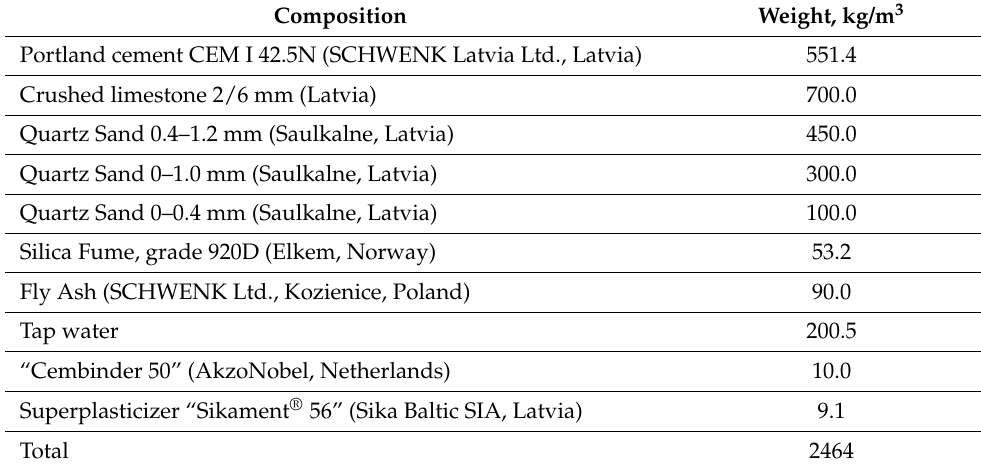
Table 3. Name of groups and fibers quantity, kg/m 3 a